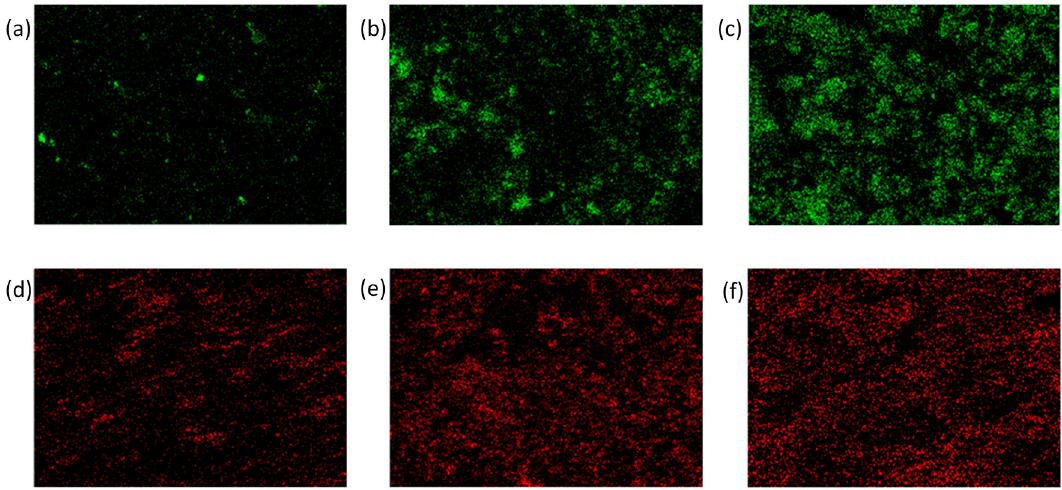
Figure 8. Energy dispersive X-ray spectroscopy (EDX) maps of Ca distribution of stabilized sample- composite: 10% ( a ), 50% ( b ), 70% ( c ) and CaCO 3 -composite 10% ( d ), 50% ( e ), 70% ( f ).